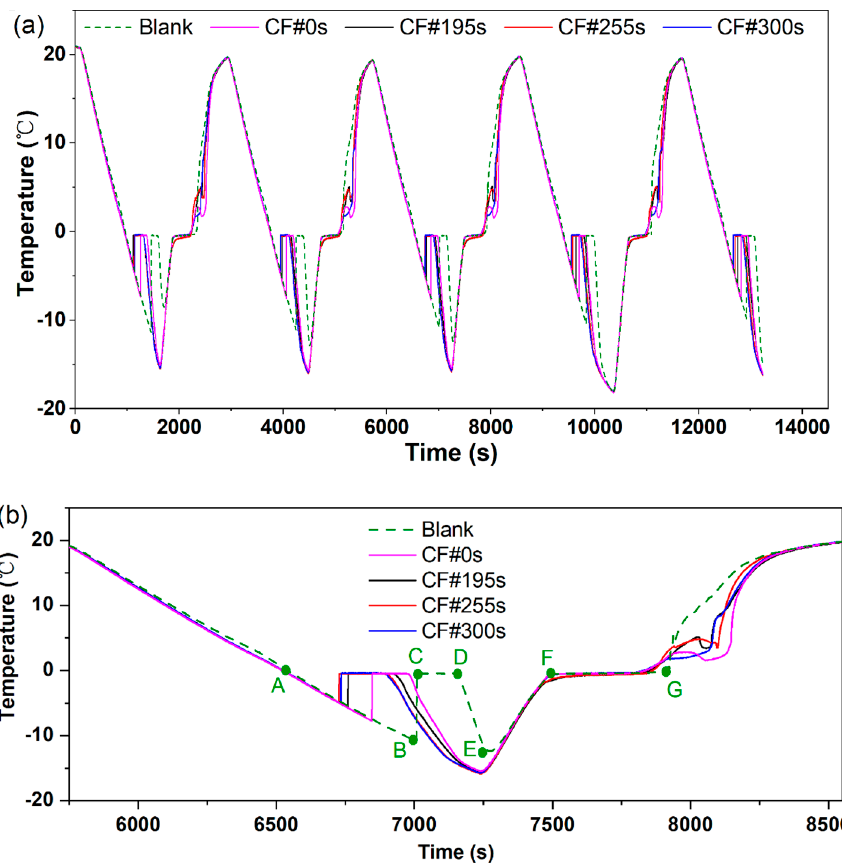
Figure 4. Temperature profiles during the cool storage phase-change process test cycles ( a ) temperature profiles of five cycles experiment ( b ) temperature profiles of the 3rd cycle.